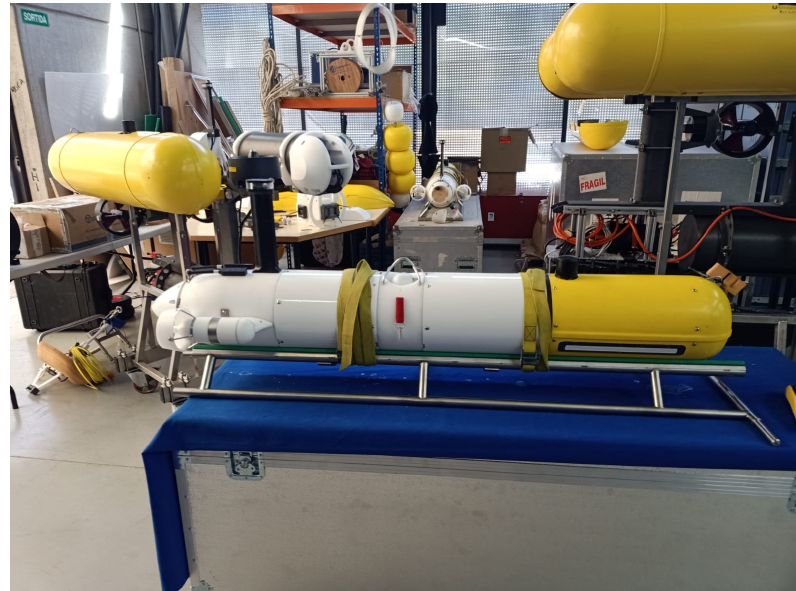
Figure 11. Photography of the Sparus